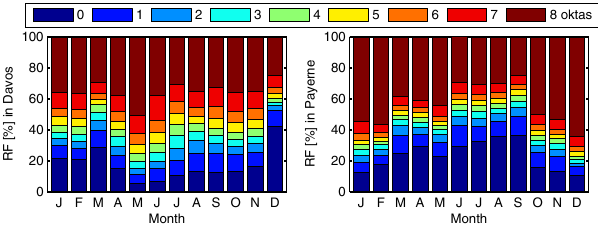
Figure 1. Relative frequencies (RF) of cloud coverages in 1- to 8- okta divisions (all cloud types together) for the two stations Davos (left) and Payerne